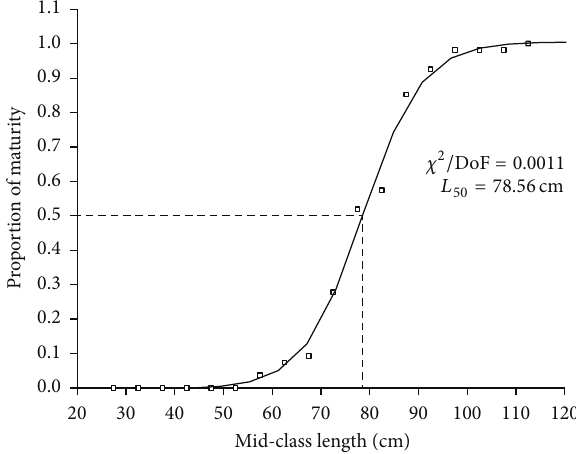
Figure 8: Proportions of sexually mature females (F3–F6) of Epinephelus malabaricus by 𝐿 𝑇 fitted to a logistic function (dashed line indicates the mean 𝐿 𝑇 at 50% sexual maturity ( 𝐿 50 ) ( 𝑁 = 143